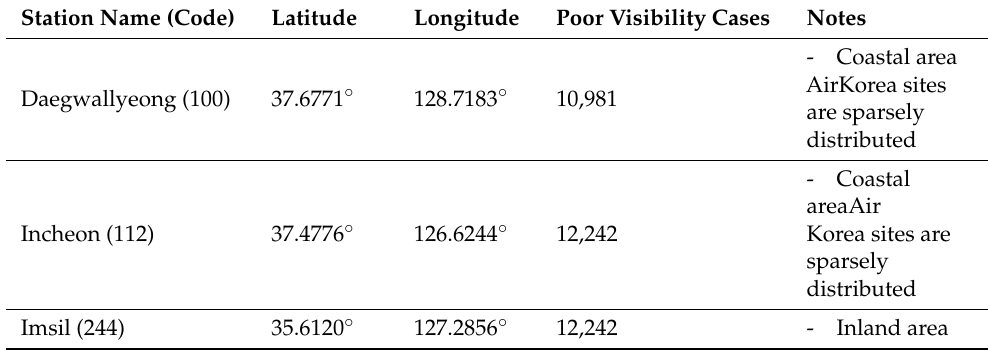
Table 4. Summary of ASOS sites for investigating effect of spatial